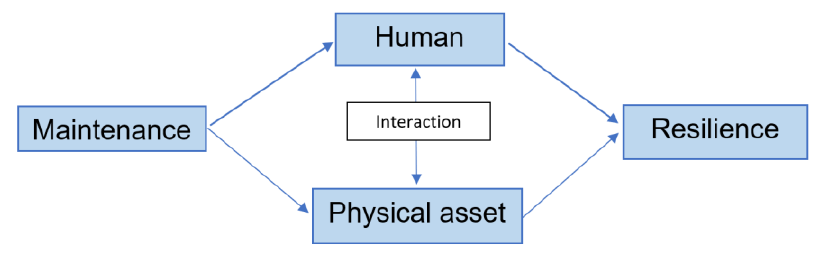
Figure 3. Research framework.